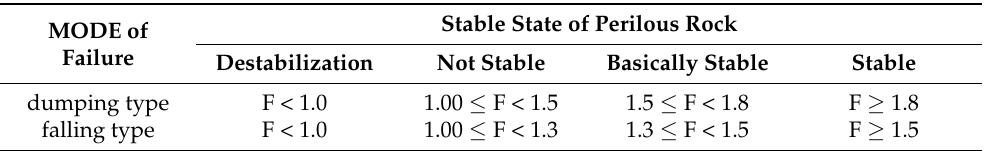
Table 3. Criteria for classification of the stability state of a perilous rock mass.